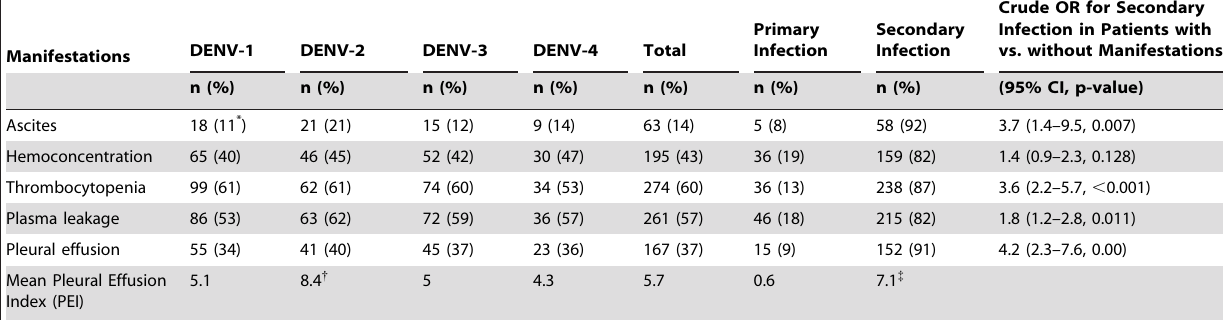
Table 3. Clinical